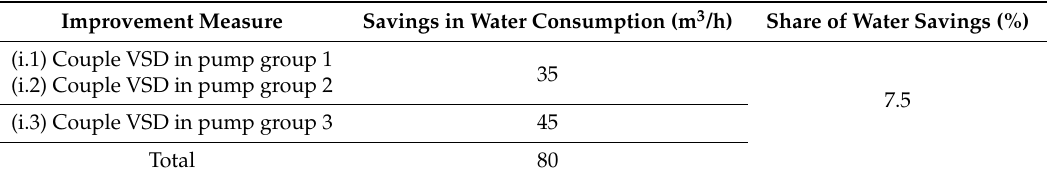
Table 9. Savings in Water